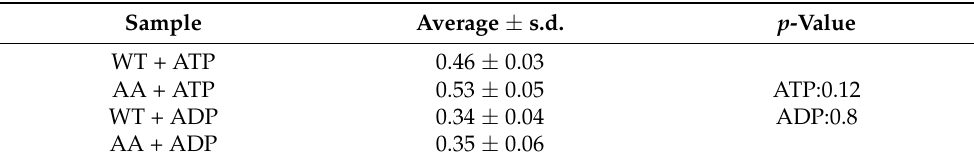
Table 2. Average and standard deviation (s.d.) of the desthiobiotin signal normalized by HA-tag